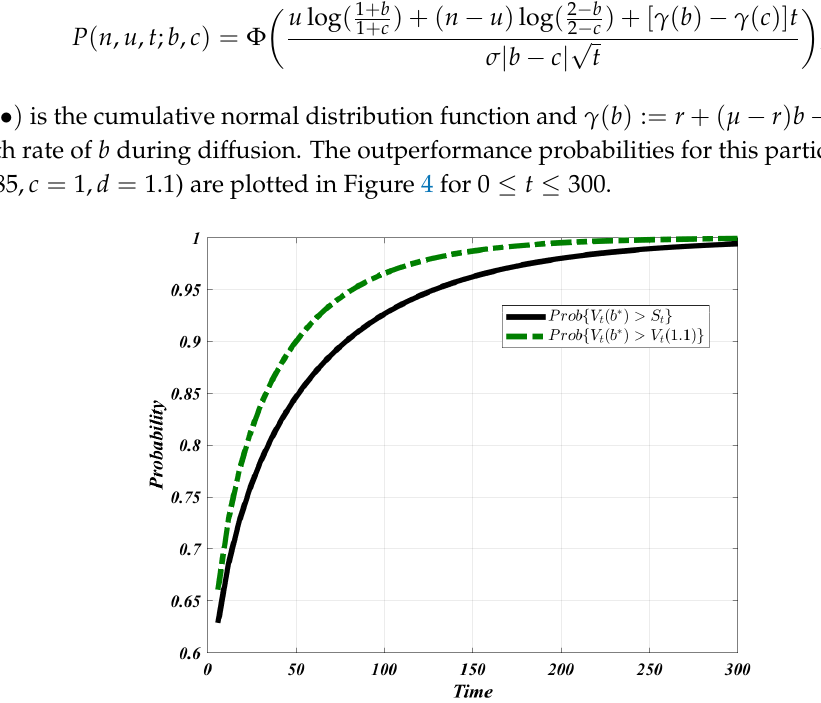
Figure 4. Outperformance probabilities over different game lengths t ∈ [ 0,300 ] for the parameters ν : = 0.07, σ : = 0.15, r : = 0.03, λ : = 1, b : = 0.585, c : = 1, d : = 1.1, x ∈ { + 100%, − 50% }